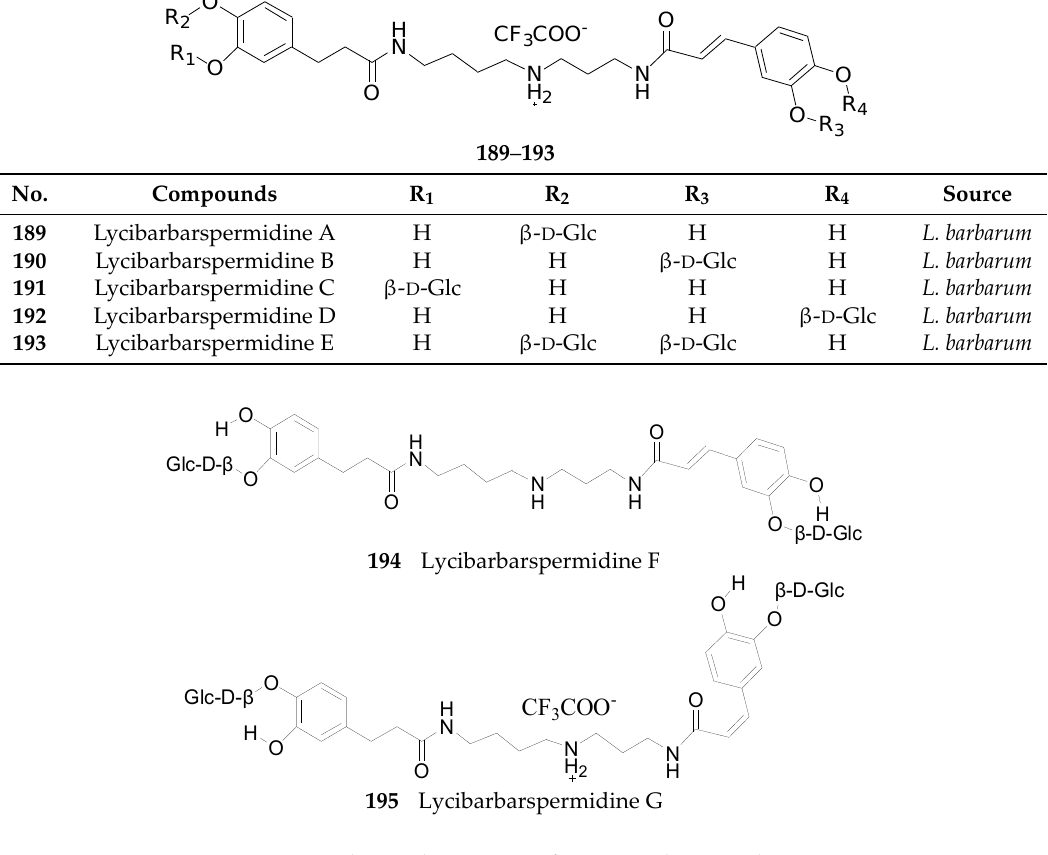
Figure 13. Chemical structures of compounds 185 – 188 . Table 9. Chemical structures of compounds 189 – 193 .